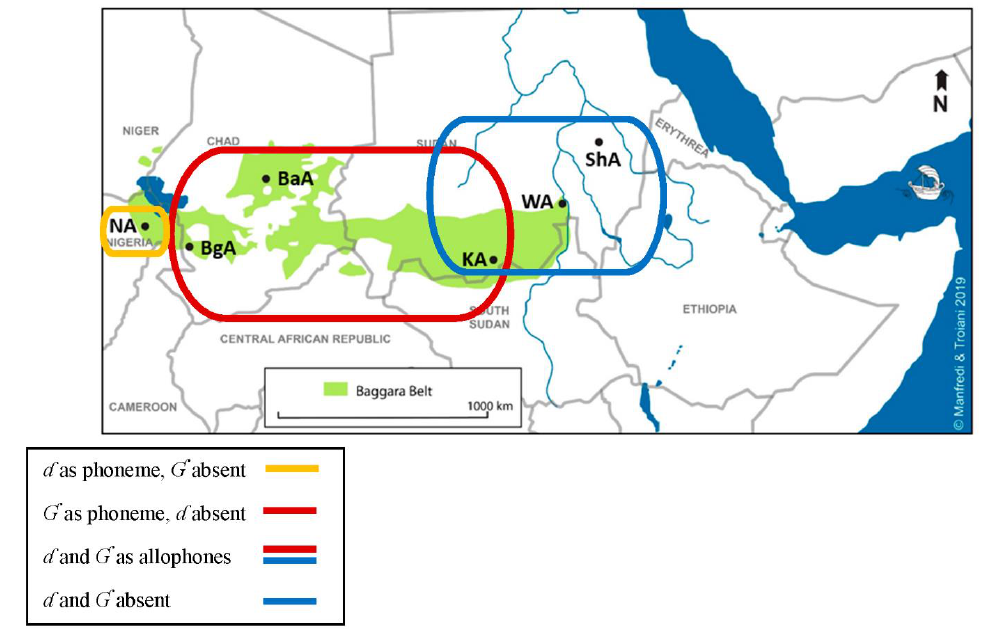
Figure 4. Implosive consonants.